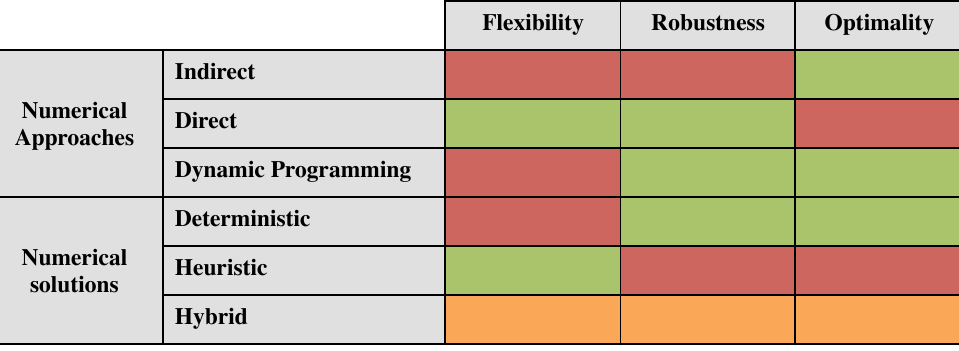
Figure 7. Methods and techniques in numerical